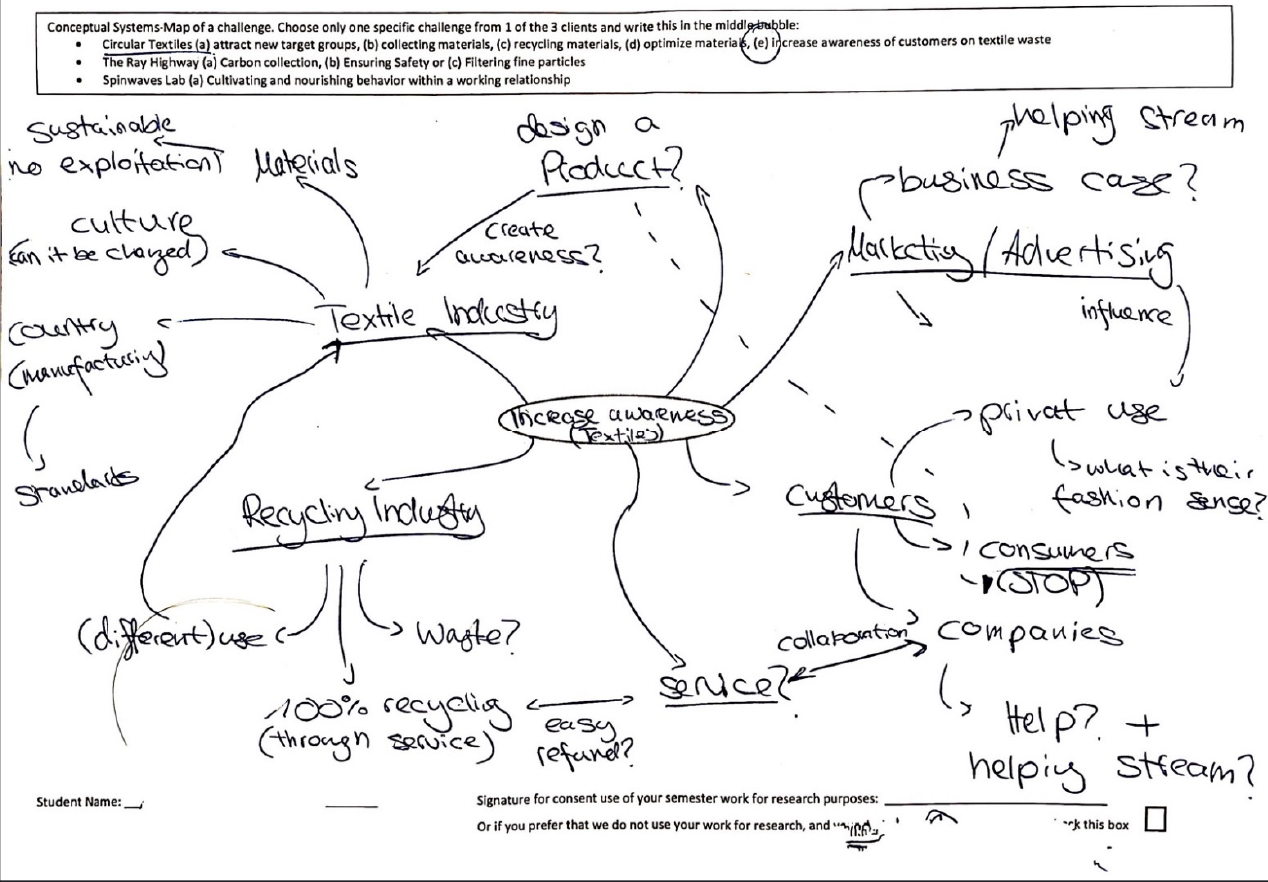
Figure 2. Example of a systems-mapping exercise.